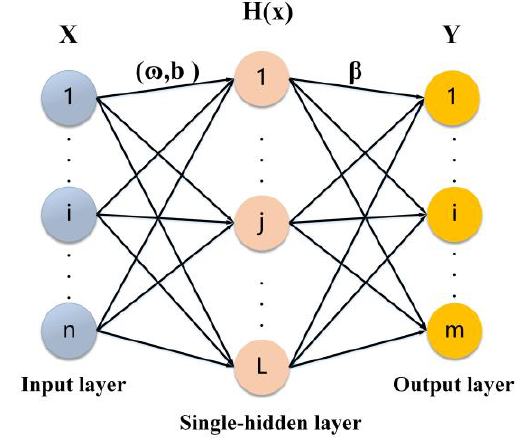
Figure 3. ELM network structure chart.